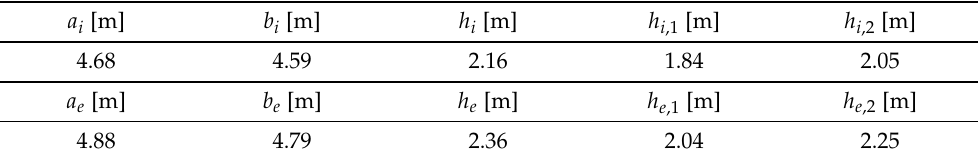
Table 1. Intrados and extrados data referring to notation in Figure 14.